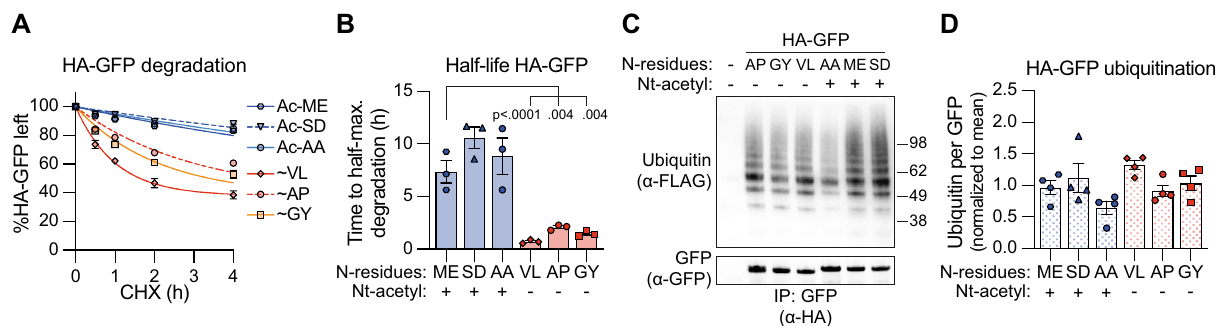
Figure 2. Nt-acetylation correlates with increased stability of HA-GFP, while it does not detectably affect its ubiquitination. ( A ) HEK 293T cells were transfected to express BFP as a reference protein, together with HA-GFP variants carrying indicated N-terminal dipeptide sequences (”Ac-” = Nt-acetylated, “ ~ ” = Nt-acetyl- free). Cells were cultured in presence of CHX (50 μg/ml) for the indicated time periods, followed by flow cytometric analysis. GFP fluorescence intensity was normalized to BFP fluorescence intensity, and set to 100% at the 0 h time point. Data points were connected by a one-phase decay curve fit (n = 3; mean ± SEM). ( B ) Based on the data in panel A, the half-life of the indicated HA-GFP variants was determined (n = 3; mean ± SEM; ratio paired t-test, two-tailed). ( C , D ) HEK 293T cells were transfected to express indicated HA-GFP variants and FLAG-tagged ubiquitin, followed by lysis under denaturing conditions. Next, HA-GFP was immunoprecipitated and the precipitates were analyzed by immunoblotting with antibodies to the FLAG tag and GFP. Panel C shows a representative image, panel D shows the quantification of the ubiquitin signal, normalized to the GFP signal (n = 4; mean ±